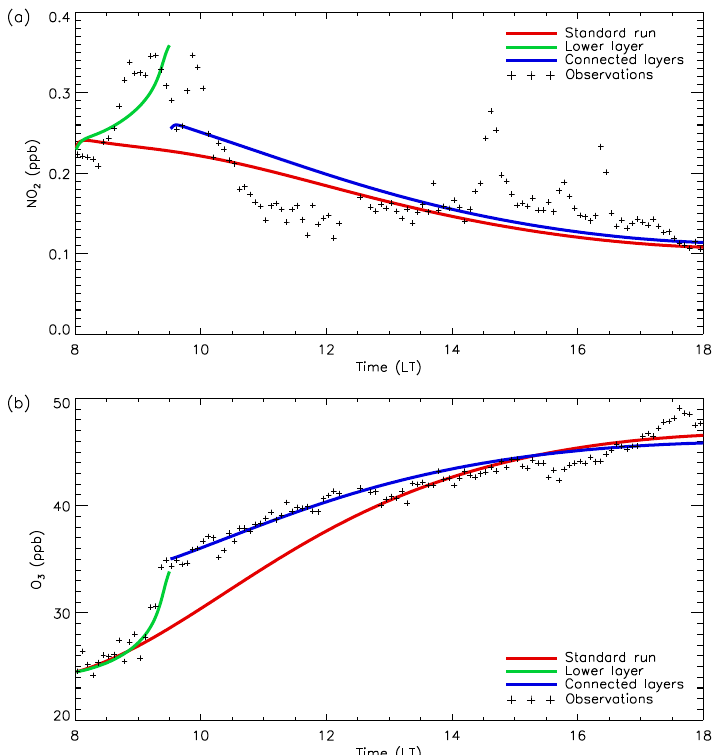
Fig. 18. Comparison between the observations and MXL model results for the (a) NO 2 and (b) O 3 mixing ratios during 6 August 2010. The numerical experiments are the standard case, the case for the lower shallow boundary layer until 09:30LT and the case where a residual layer and the lower shallow boundary layer are connected and become one mixed layer from 09:30LT onward. The latter two cases correspond to situation (1) and situation (3) in Fig. 12, respectively.